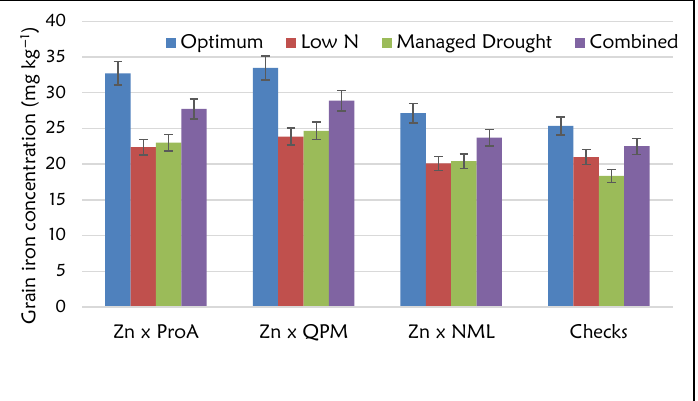
Figure 5. Grain iron concentration (mg kg − 1 ) for the Zn-enhanced normal (Zn × NML), provitamin A (Zn × ProA) and QPM (Zn × QPM) testcross hybrids and checks evaluated under stress and non-stress environments.